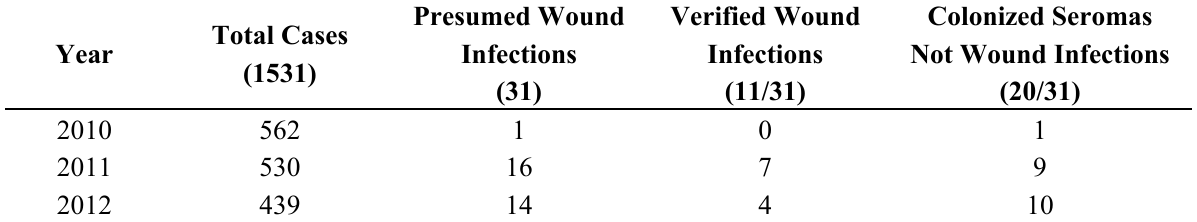
Table 1. Winthrop-university hospital, recent experience with potential post-laminectomy wound